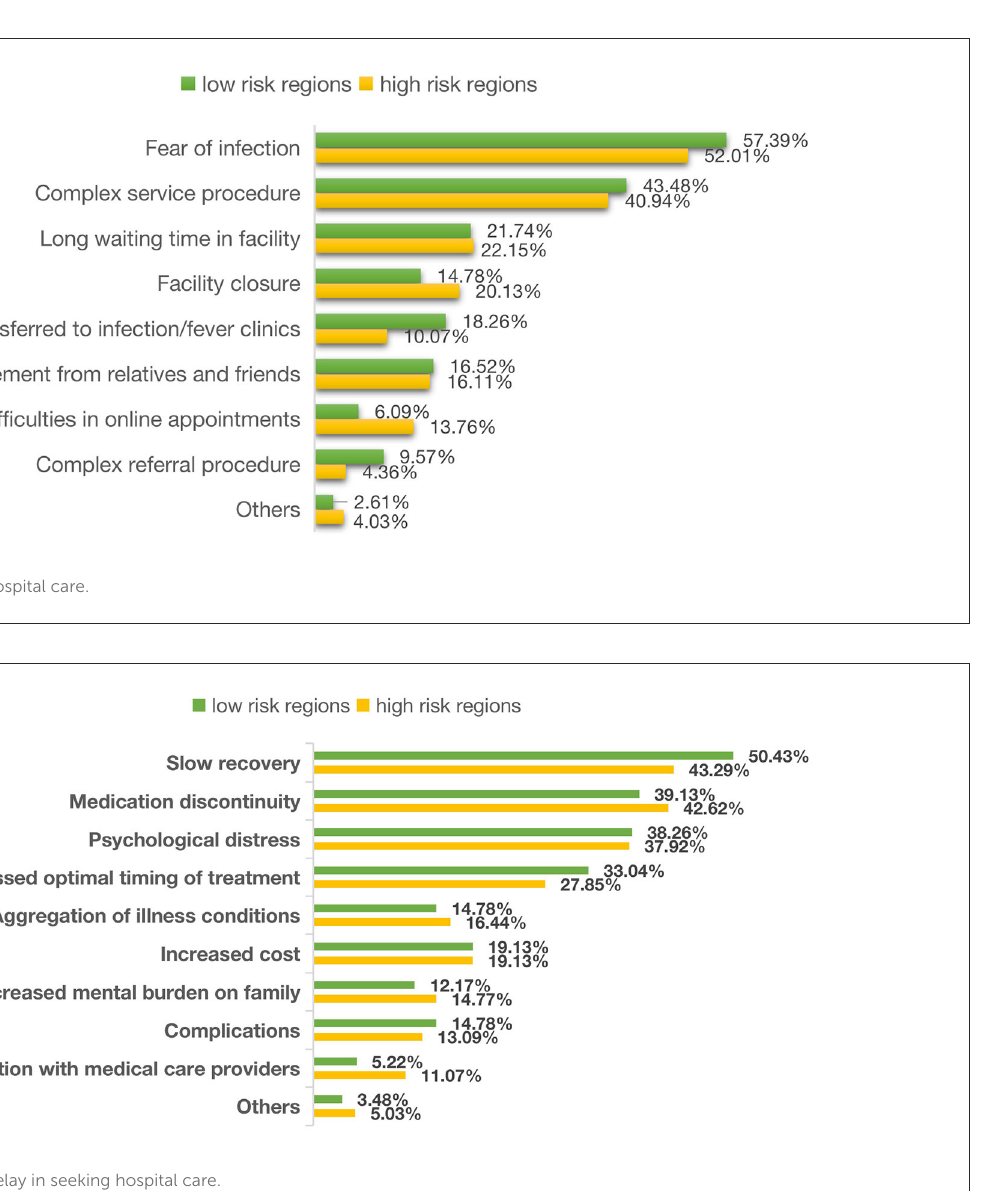
FIGURE2 Perceived consequences of delay in seeking hospital